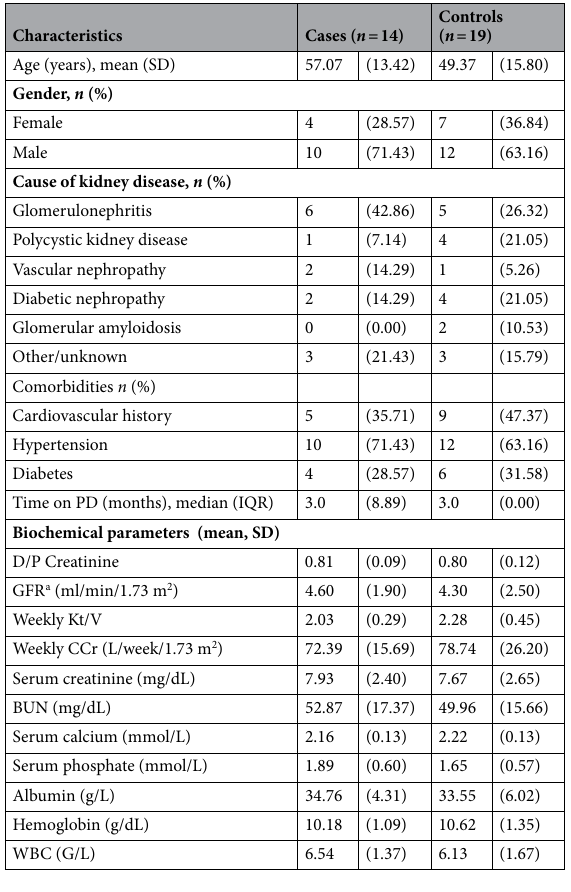
Table 1. Demographic data and biochemical parameters at the start of the observation period. a The mean GFR was calculated as average value of creatinine and urea clearance using 24-h urine collections. For all parameters, P values > 0.05 when comparing cases vs controls (two-tailed MWU test). BUN, blood urea nitrogen; CCr, creatinine clearance; GFR, glomerular filtration rate; WBC, white blood cell